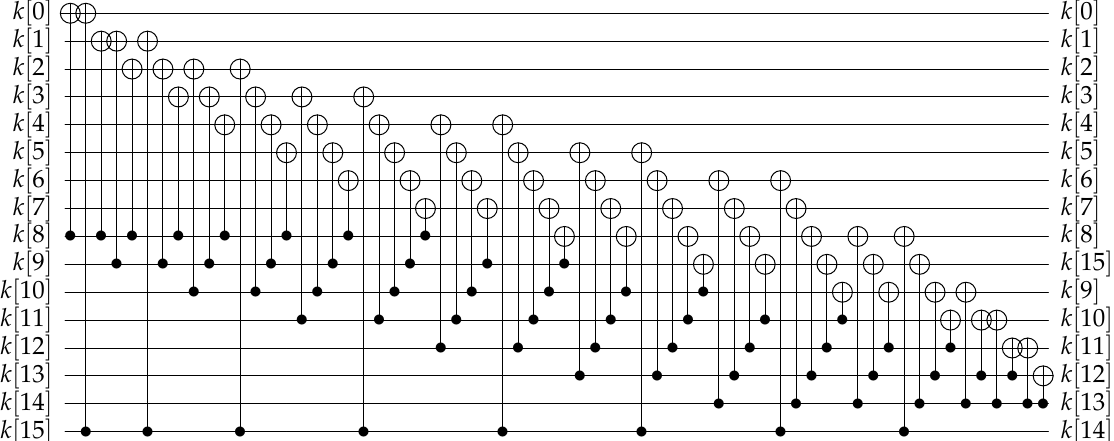
Figure 2. Quantum circuit of the CHAM-64/128 key schedule with PLU factorization (Apply_U), white circle indicates XOR operation and black dot indicates